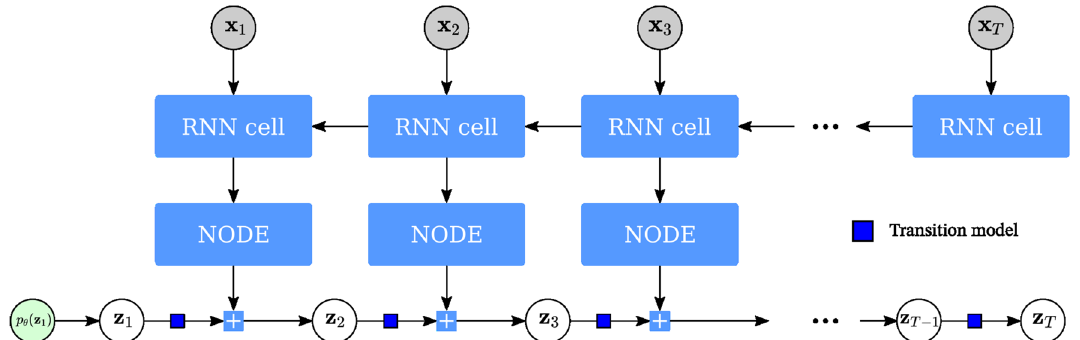
Figure 5. RNN-NODE encoder: Observations at time t are augmented to the latent space dimension using a RNN network. We use an RNN instead of a regular neural network so as to pass long-term dependencies to